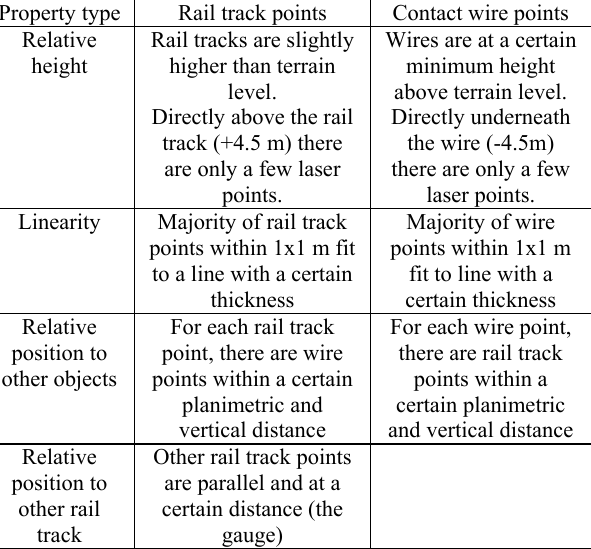
Table 1. Properties of points on rail tracks and contact wires.